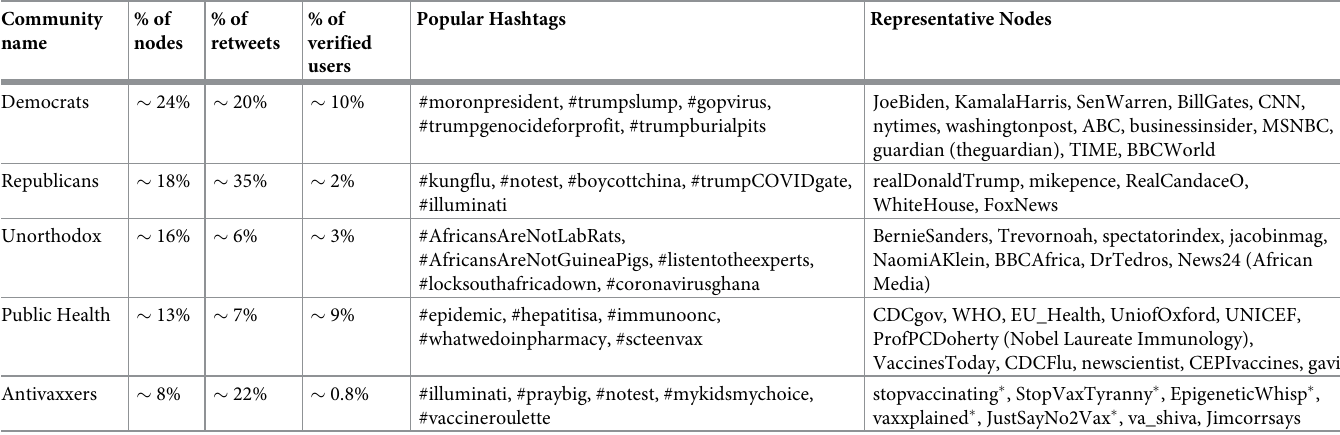
Table 1. Summary statistics for the top five communities.